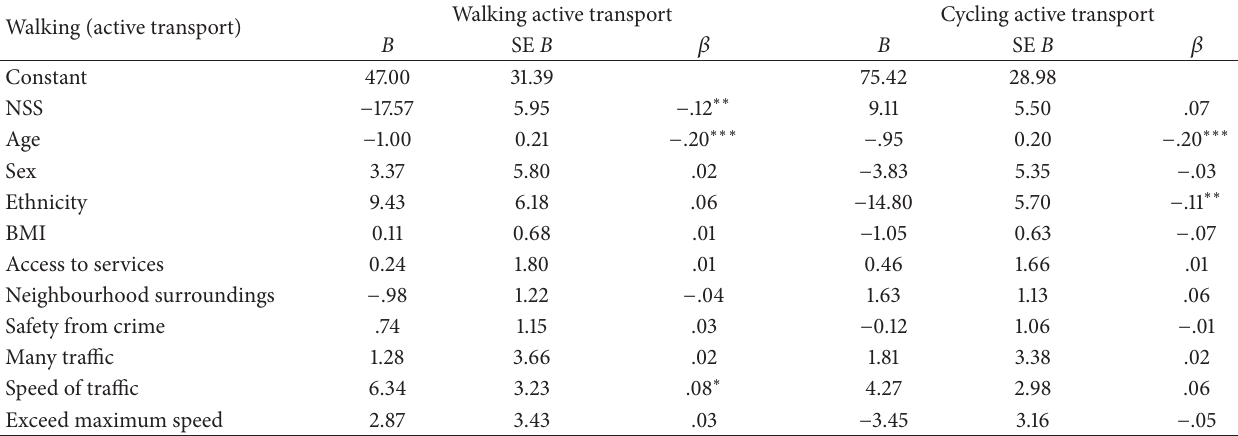
Table 3: Multivariate regression regarding minutes per week of walking and cycling for active